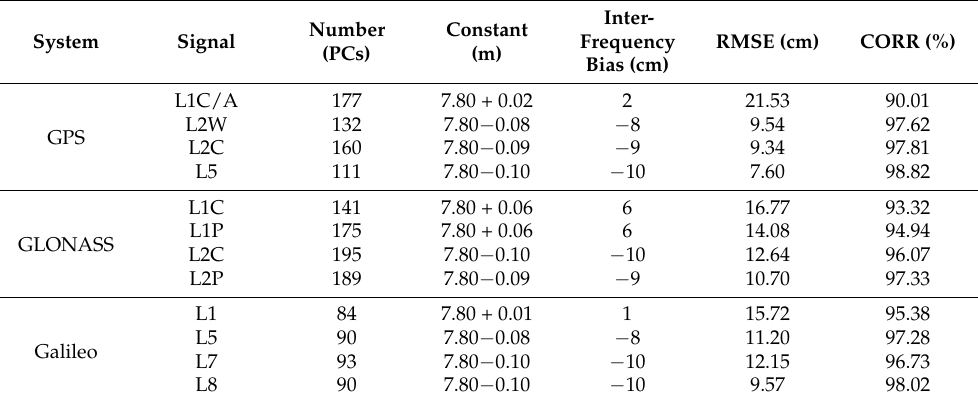
Table 2. Numbers of RH retrievals, constant, inter-frequency bias, RMSE, and CORR between sea-level retrievals and sea-level measurement for each